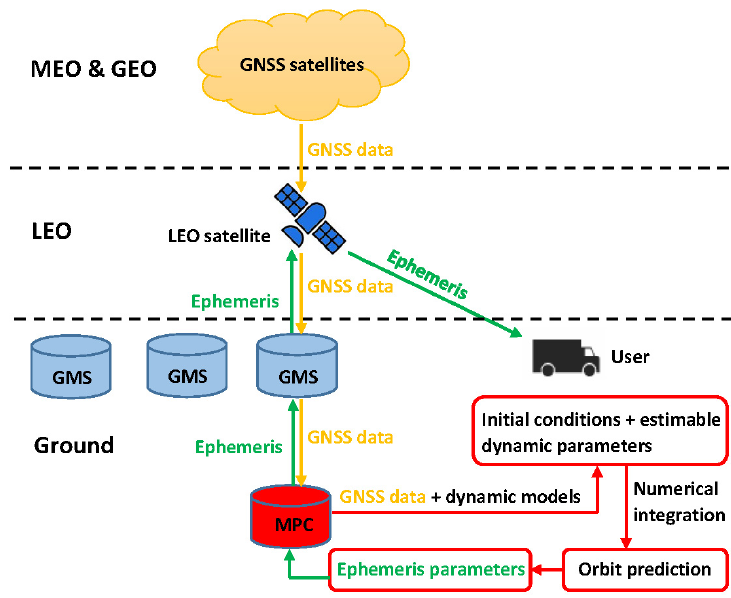
Figure 1. The processing procedure of the Level A orbital products.